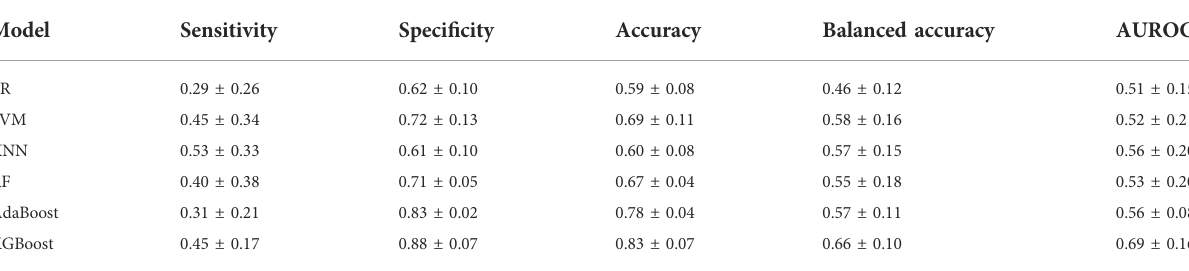
TABLE 4 Cross-validation results from six different machine learning algorithms (mean ± standard deviation). Cross-validation results